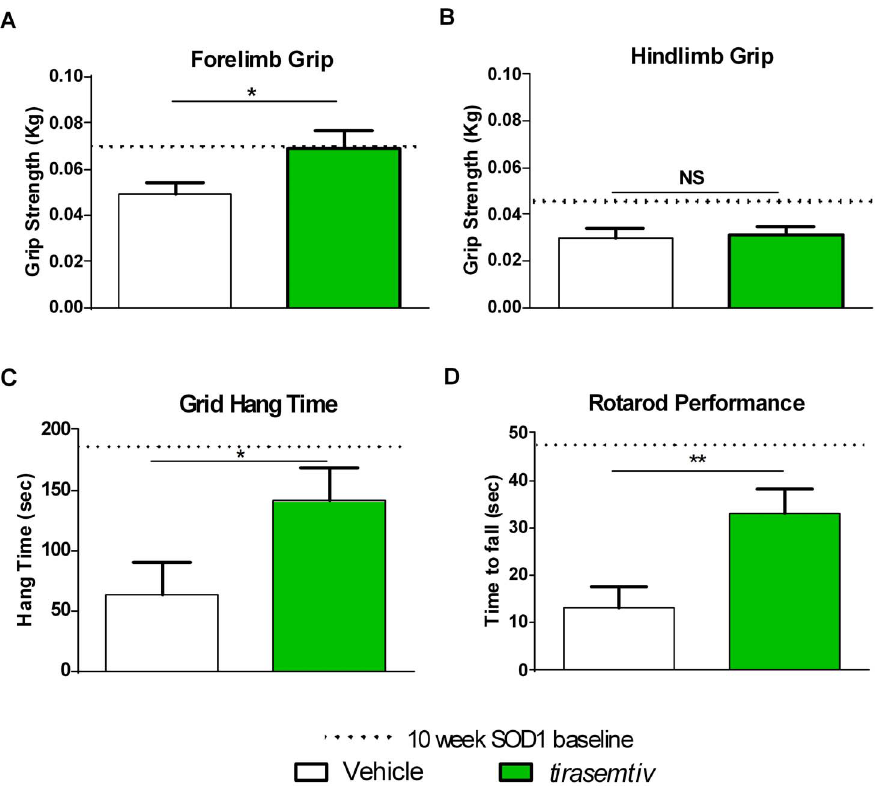
Figure 4. Tirasemtiv increases forelimb grip strength, grid hang time, and rotarod performance in female B6SJL-SOD1 G93A mice. Effect of tirasemtiv at 25% (approx. 90–110 days) forelimb grip strength loss milestone compared to 10-week old baseline on (A) Forelimb grip, (B) Hindlimb grip, (C) Grid hang time, and (D) Rotarod performance. Dotted line shows mean B6SJL-SOD1 G93A transgenic mouse performance assay values at baseline (10 weeks of age). Data are expressed as mean 6 SEM. n=10–12/group. *=p , 0.05, **=p , 0.01 vs. WT by one way